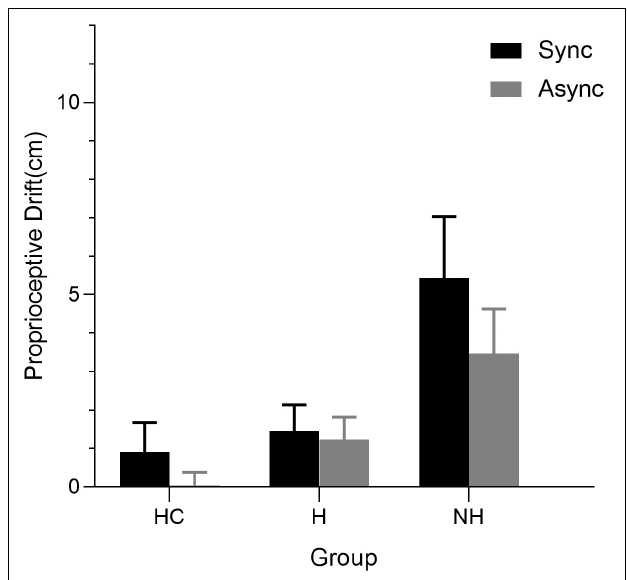
FIGURE 2 | Mean proprioceptive drift of patients with auditory verbal hallucinations (AVHs) (H), patients without AVHs (NH), and HCs under two stimulation conditions: synchronous (Sync) and asynchronous (Async). Error bars reflect 95% confidence